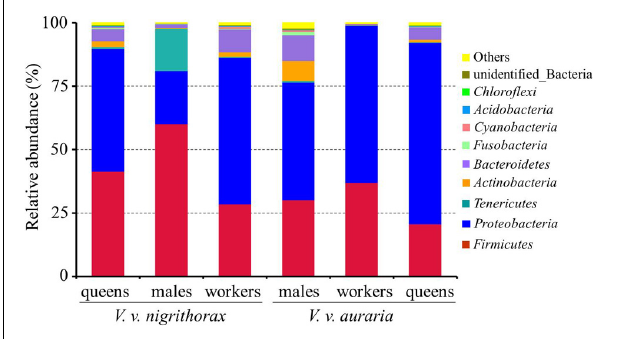
FIGURE 2 | Relative abundance of the dominant midgut bacterial communities in Vespa velutina nigrithorax and Vespa velutina auraria at the phylum level. Each bar represents the average relative abundance of each bacterial taxon within a